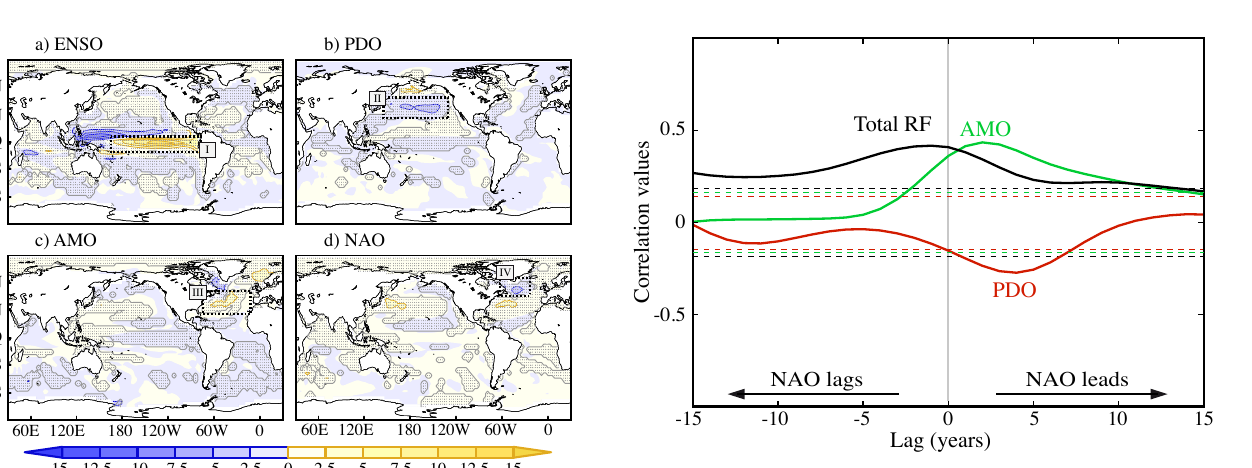
Fig. 14. Time-lag correlations between the decadally low-pass fil- tered indices of the NAO and the following time series: the PDO (red line), the AMO (green line), and the total radiative forcing (black line). Correlations are calculated for the complete FOR2 sim- ulation. The thin coloured horizontal lines represent the threshold value for significance associated with each series. Significance is addressed as in Fig.